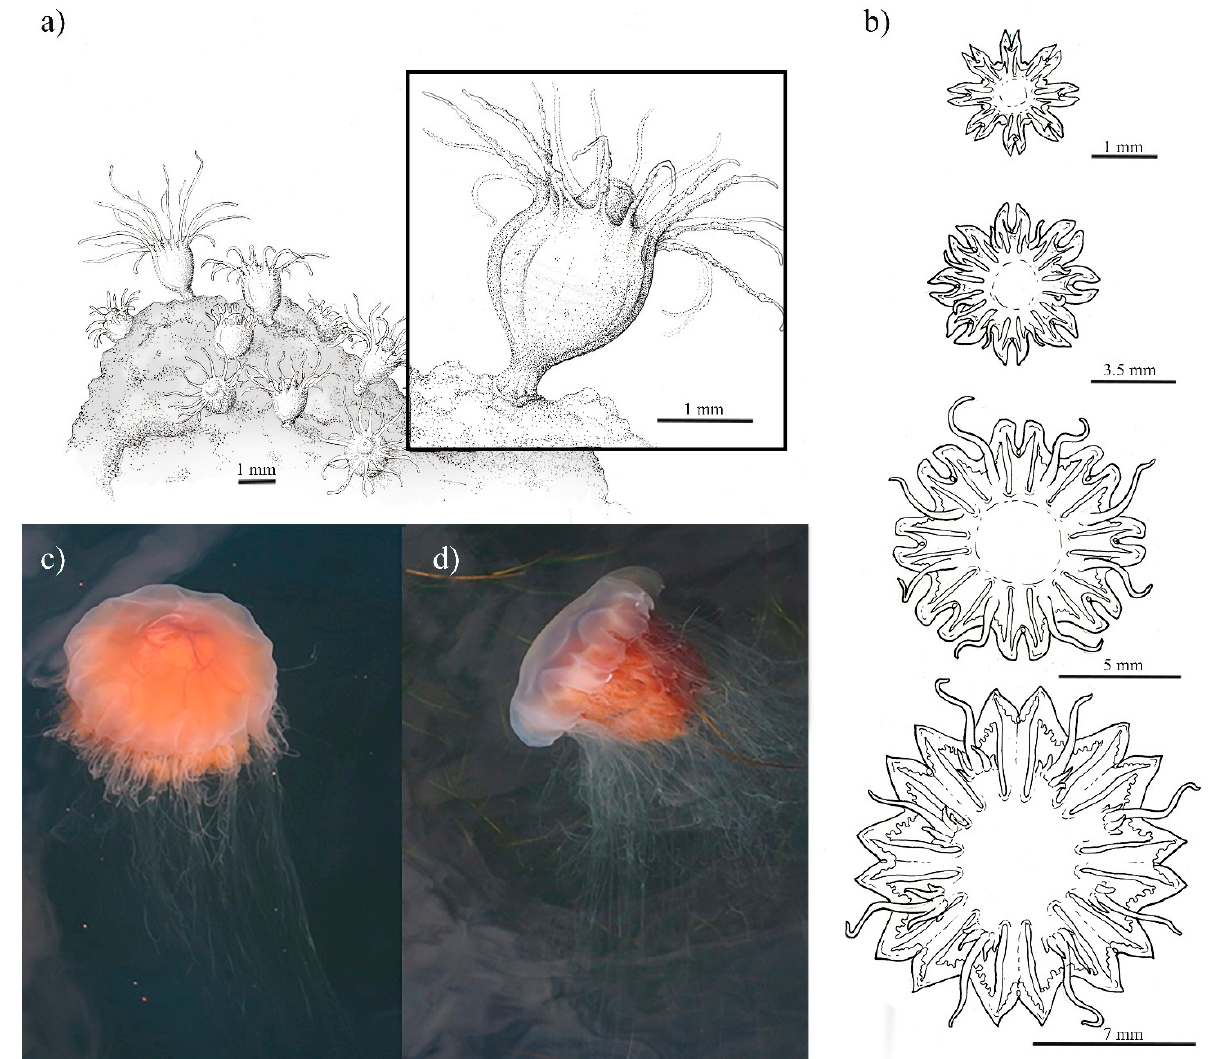
Figure 4. The Lion’s mane jellyfish Cyanea capillata ( a ) with polyp colony and close up of an individual polyp (inlet), ( b ) development sequence of ephyra, ( c , d ) medusae (ca. 35 cm) in Kiel Fjord, Sept. 2014. Image credit ( a , b ): N. Bezio, ( c , d ): C. Jaspers.